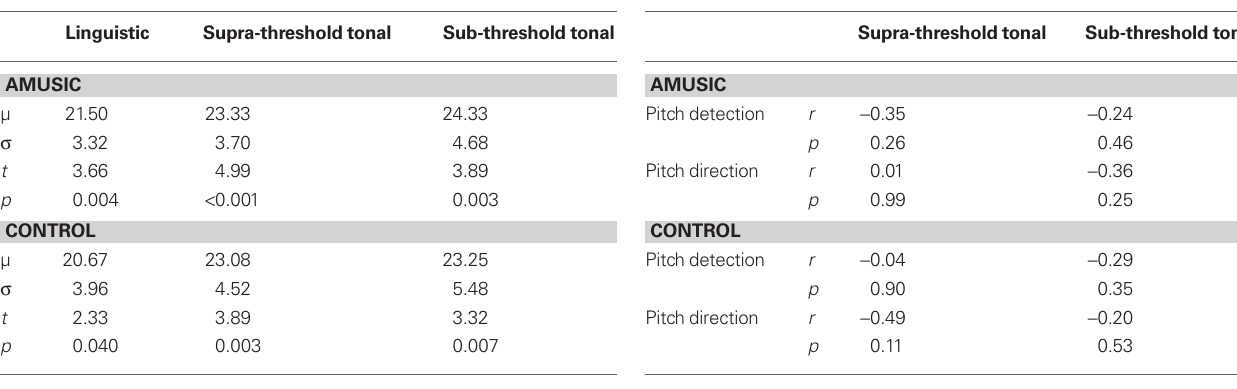
Table 3 | means, sD, and results for one sample t -tests (df = 11) against chance performance for amusic and control individuals across all three conditions.